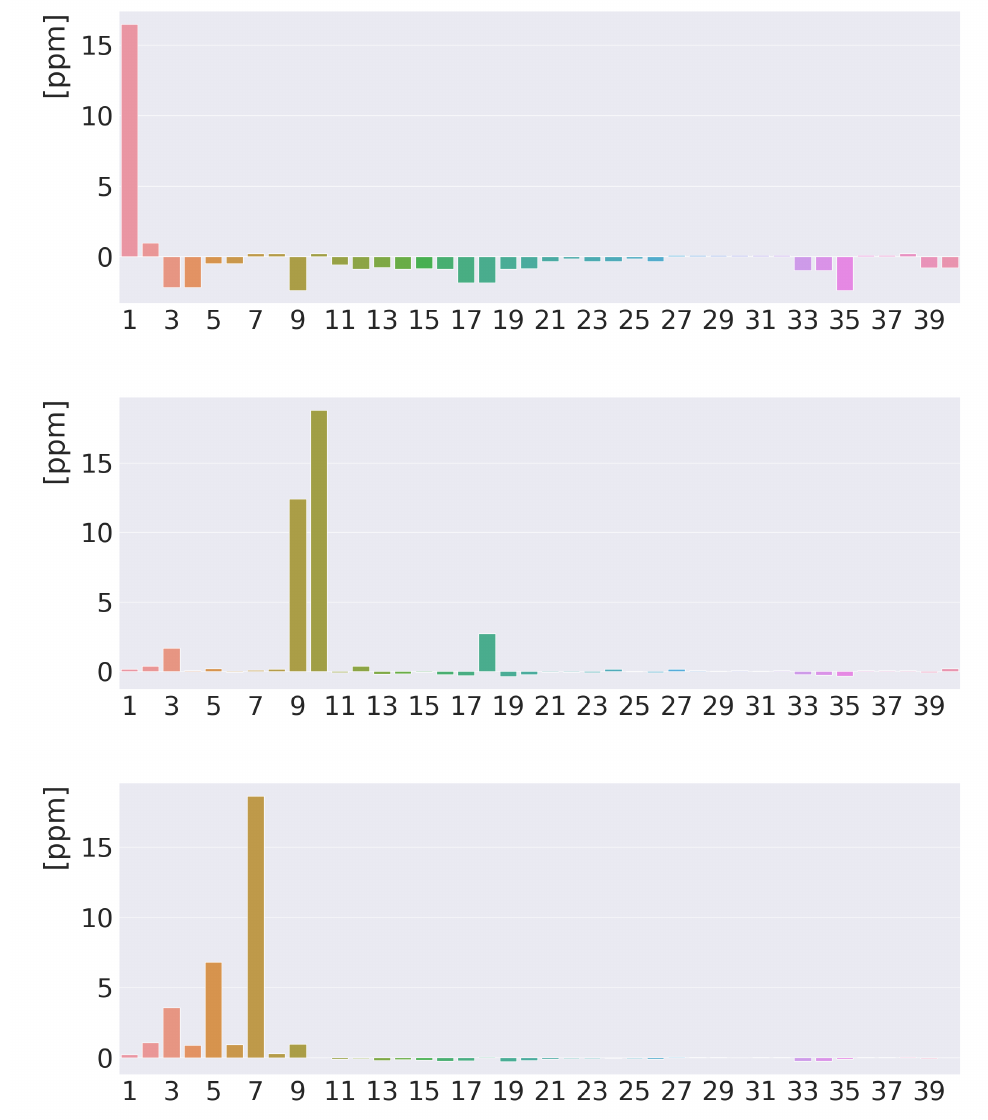
Figure 8. Atomic contributions (in ppm) to the isotropic 1 H NMR shielding constants of free-base isophlorin. From above: the inner hydrogen, the meso hydrogen, the β hydrogen atoms of the pyrrole ring. The atoms are numbered along the x axis in the same order as in